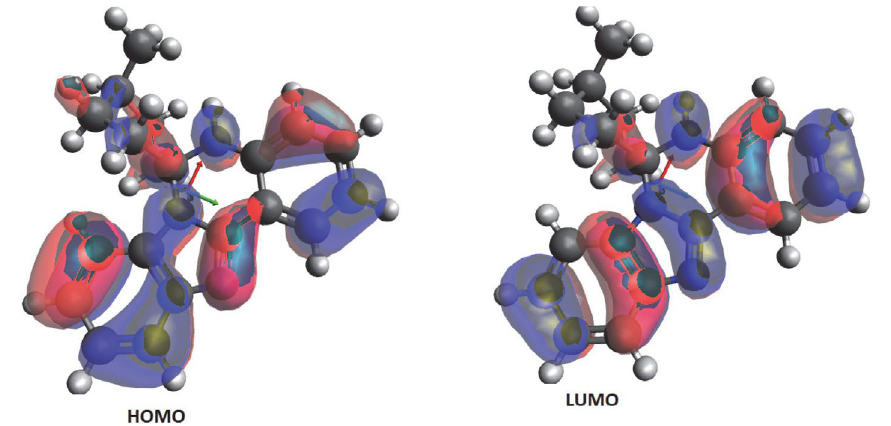
Figure 3. HOMO–LUMO of compound I c omputed using